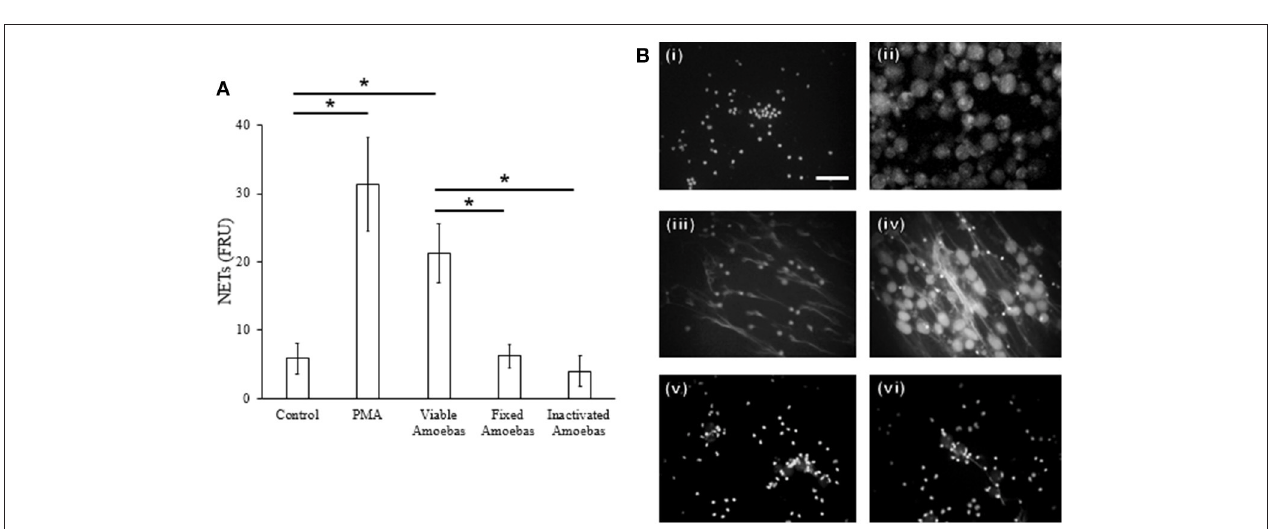
FIGURE 5 | NET release depends on amoeba viability. (A) Neutrophils (3 × 10 5 ) were co-cultured with viable, formaldehyde-fixed or heat-inactivated trophozoites (1.5 × 10 4 ) in RPMI medium for 4h. PMA at 20nM was used as positive control of NETosis. Supernatants were collected, mixed 1:1 with SYTOX Green (500nM) and fluorescence was measured. NETs amount is expressed in fluorescence relative units (FRU). Values are means ± SD of three independent experiments in triplicate. * p < 0.001. (B) Neutrophils were stimulated with 20nM PMA or viable or non-viable amoebas (ratio 20:1) during 4h; cells were fixed and staining with DAPI. Control neutrophils (i), control amoebas (ii), neutrophils treated with PMA (iii), neutrophils co-cultured with viable (iv), fixed (v), or heat-inactivated amoebas (vi). Images were taken at 60x magnification. Scale bar 50 µ m.